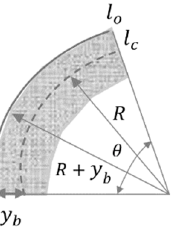
Figure 3. Schematic of the bending of the printed actuator.